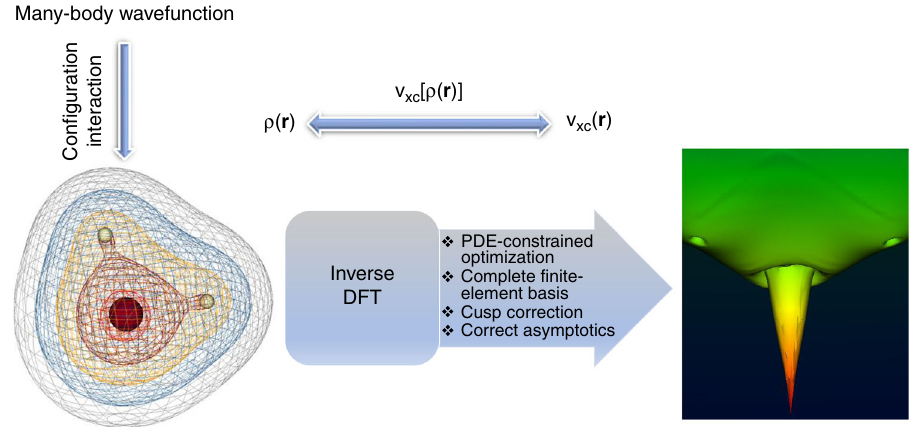
Fig. 1 Schematic of the inverse DFT problem. The exact ground-state many-body wavefunction ( Ψ ð r 1 ; r 2 ; ¼ ; r N density ( ρ ð r Þ ) is obtained from con fi guration interaction calculation. The inverse DFT calculation evaluates the exact exchange-correlation potential ( v that yields the given ρ ð r Þ . The ability to accurately solve the inverse DFT problem, presented in this work, presents a powerful tool to construct accurate ρ ð r Þ(cid:2) ), either through conventional approaches or via machine learning. The schematic shows the ground-state density and the density functionals ( v xc ½ exact exchange-correlation potential for H obtained in this 2 O